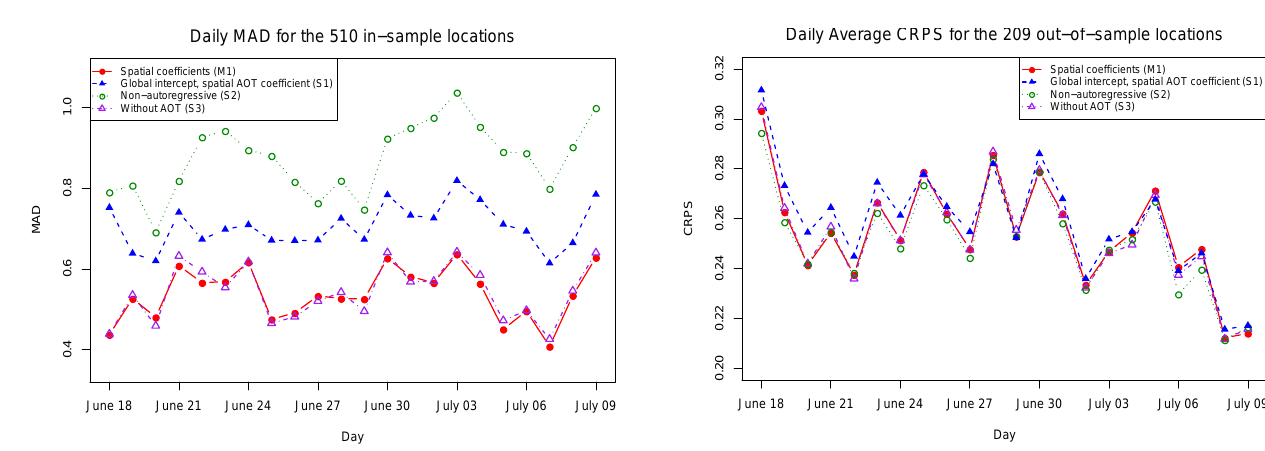
Figure 6. Daily MAD for in-sample locations for 18 June– 9 July 2013 under the competing models, (Eqs. 2–6), where MAD is given in units of µgm − 3 .